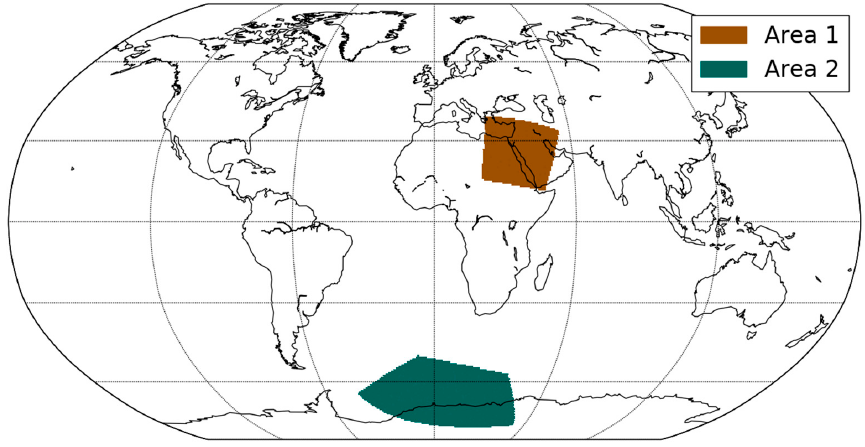
Figure 1. Test areas chosen for visualization of problematic channel 3b noise conditions in one selected NOAA-7 AVHRR GAC orbit from 1 January 1983 (see Figures 2 and 3).